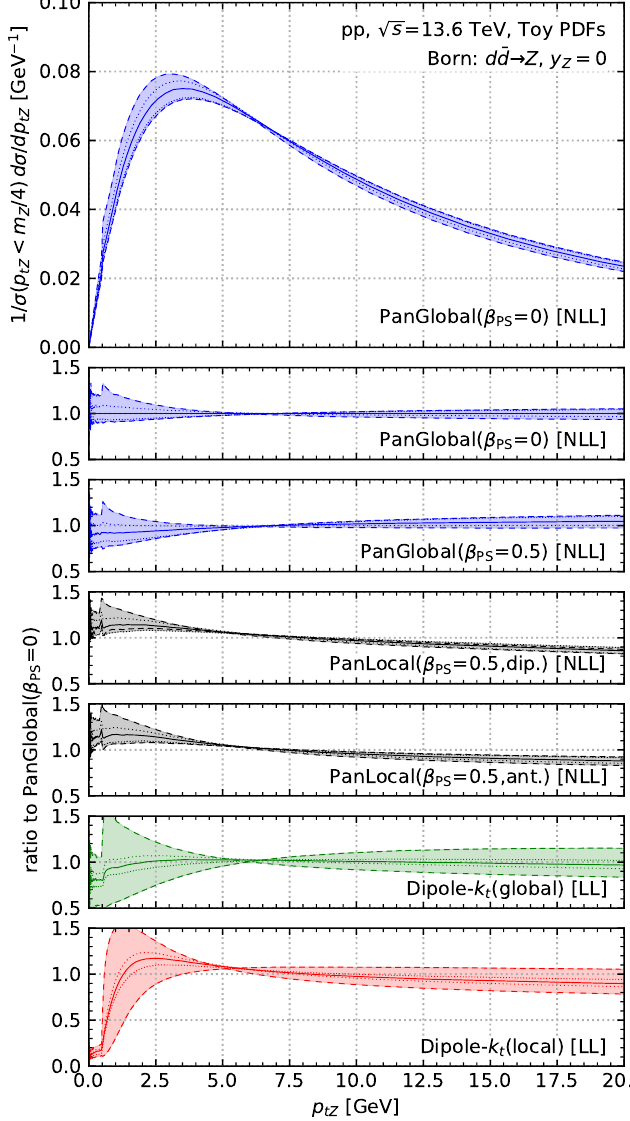
Figure 9. The p tZ distribution as predicted in a variety of parton showers. The plots use a semi-physical setup, for a pp centre-of-mass energy 13 . 6 TeV . The Born events involve d ¯ d scattering with a Z rapidity of zero, and the showers use 5-flavour toy PDFs defined through the initial condition of eq. (A.6) at a scale of 0.5 GeV. The top panel shows the p tZ distribution with the PanGlobal ( β ps = 0 ) shower and the remaining panels show the ratio to that distribution for each of several showers. For each shower, the band corresponds to the envelope of the renormalisation scale ( x r ) variations (dashed lines) and factorisation scale ( x f ) variations (dotted lines), as described in the